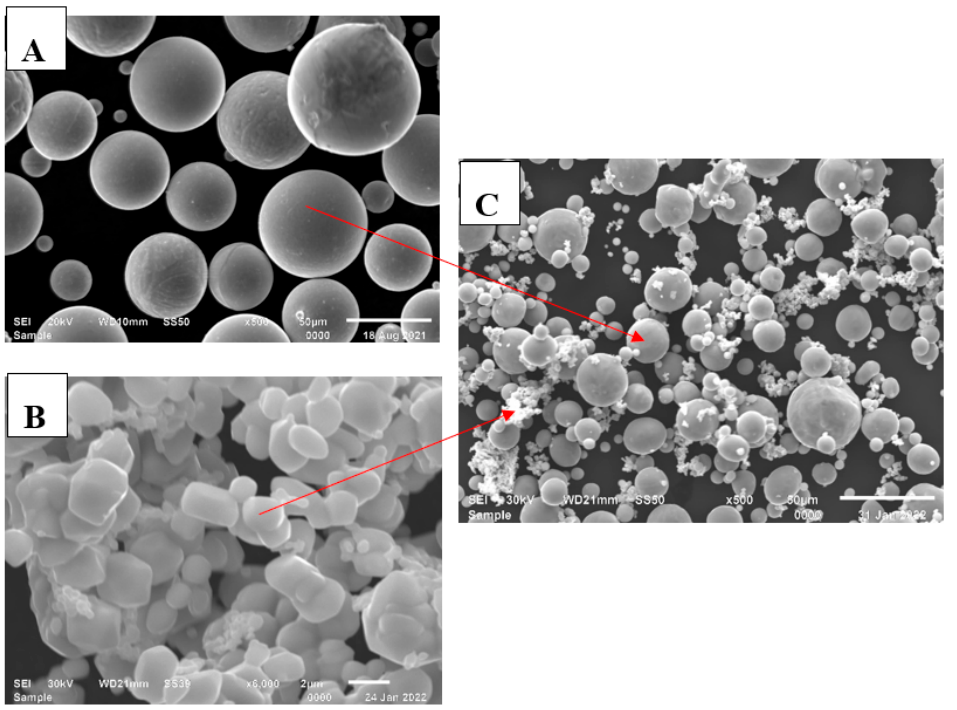
Figure 1. SEM images of the powders: ( A ) Cp Ti powder, ( B ) Mo powder, and ( C ) Ti5Mo powder blend.